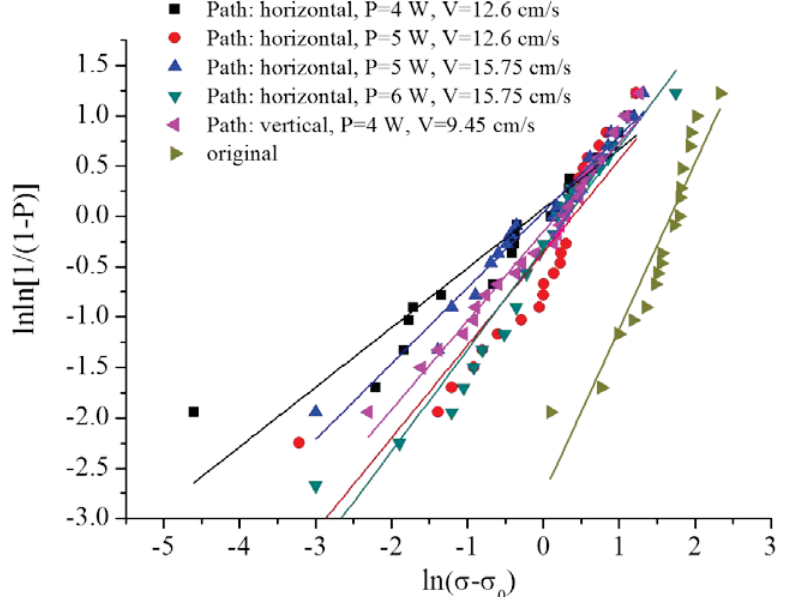
Figure 20. Weibull